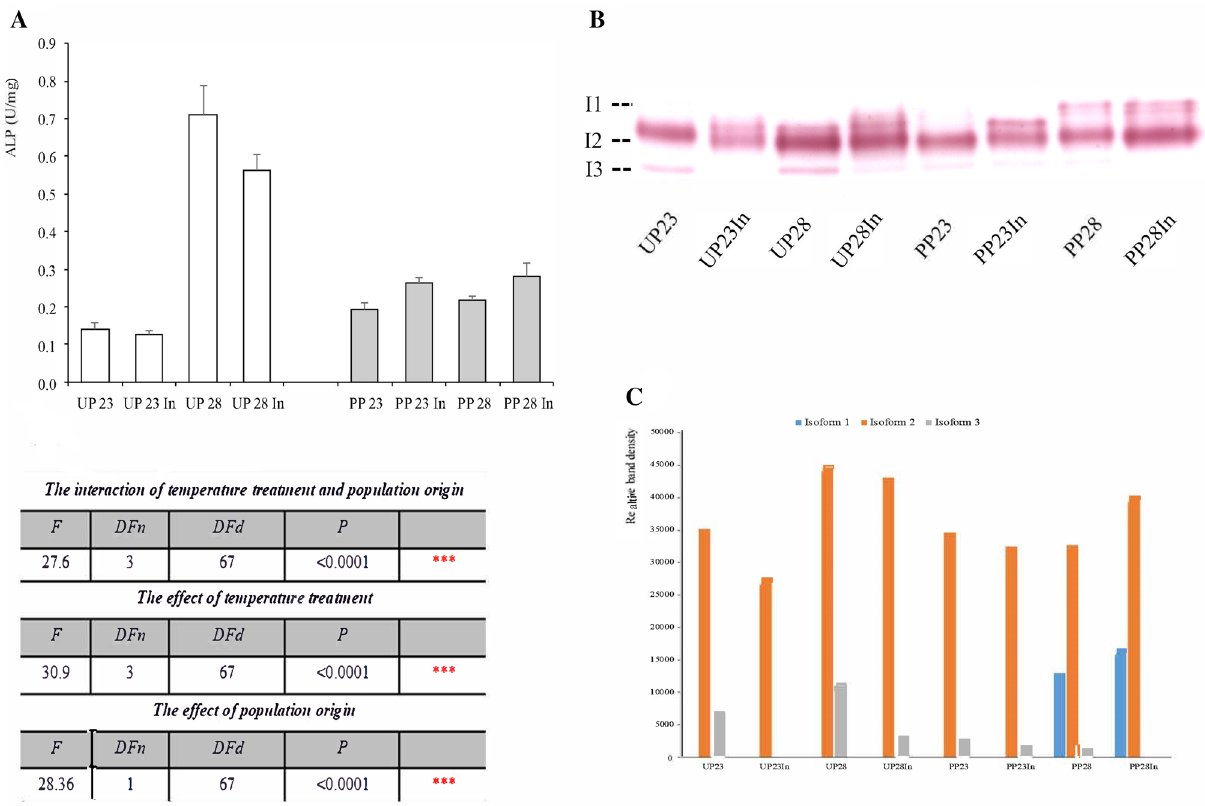
Figure 1. The specific activity of ALP in the midgut of 5th instar Lymantria dispar larvae exposed to different temperature treatments from unpolluted (UP) and polluted forest (PP) ( A ); UP 23 and PP23—larvae reared on 23 °C from hatching to sacrification; UP 23In and PP 23In-larvae reared on 23 °C from hatching until the first day of 4th instar, and then exposed to temperature of 28 °C for 24 h (induced thermotolerance). Afterwards they were returned to 23 °C until the third day of 5th larval instar; UP 28 and PP23—larvae reared on 23 °C from hatching until the first day of 5th larval instar, and then exposed to temperature of 28 °C for 72 h; UP 28 In and PP 28 In-larvae reared on 23 °C from hatching until the first day of 4th instar, and then exposed to temperature of 28 °C for 24 h (induced thermotolerance). Afterwards they were returned to 23 °C until the first day of 5th larval instar, and then exposed to temperature of 28 °C for 72 h. Error bars indicate the standard error of the mean (SEM) for (n = 8–11). Significance of the effects of the thermal treatments, population origin, and their interaction on the variance of ALP activity with thermal treatments as fixed factor (two-way ANOVA, p ≤ 0.05). Native PAGE gels stained for ALP with enzyme isoforms ( B ), and densitometric analysis of the bands using Image J program ( C ). Gel is cropped, and original gels are presented in Supplementary information, Figs. 1 and on the gel (Fig. 2b). Isoform 1 was present only in PP groups. Isoform 2 had a higher density in both populations and all treatments in comparison to controls. High band density of isoform 3 was present in all experimental groups, while induced thermotolerance and increased temperature led to high band density of isoform 4 in both populations (Fig. 2c). Induced thermotolerance affected the activity of tot ACP in caterpillars originating from the unpolluted forest, while in caterpillars from the polluted habitats, it was decreased in all treatments, and a new isoform band was detected on NATIVE gels. Changes in lys and non-lys ACP activity in all experimental groups are presented in Fig. 3a and b, respectively. In larvae originating from the unpolluted forest, the activity of this enzyme was decreased at all temperature treatments in comparison to the control group, while the situation was opposite in polluted forest`s groups, where its activity was increased at all thermal regimes (Fig. 3a). Two-way ANOVA analysis (Fig. 3a) revealed that the interaction of temperature treatment and population origin was extremely significant (F 3, 70 = 8.91, p < 0.0001), whereas the effect of temperature treatment was considered very significant (F 3, 70 = 4.56, p = 0.0056). The activ- ity of non-lys ACP is presented in Fig. 3b. In larvae from the unpolluted forest, the activity of this enzyme was increased only in the UP28In group of larvae originating from unpolluted forest, while this enzyme’s activity did not change in treatments with larvae originating from the polluted forest, except for the decreased activity in the PP28 group from polluted forest. The interaction between temperature treatment and population origin was found to be very significant (two-way ANOVA, F 3, 71 = 5.20, p = 0.0026), and the effect of temperature treat- ment was extremely significant (two-way ANOVA, F 3, 71 = 9.96, p < 0.0001). The influence of population origin was considered significant (two-way ANOVA, F 3, 71 = 3.98, p = 0.0499).